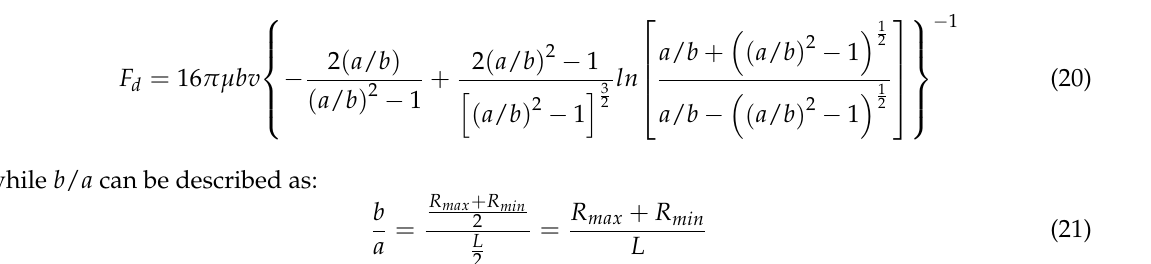
Figure 7. The velocity versus length-radius aspect ratio: ( a ) change the radius R max , keeping L = 9.1 µ m constant; and ( b ) change the length L, keeping R max = 1.16 µ m constant. The drag force used in Equation (7) is a simplified form for a spheroid with semi-axes a and b in Figure 2b. Its original form on the ellipsoid is [39]: